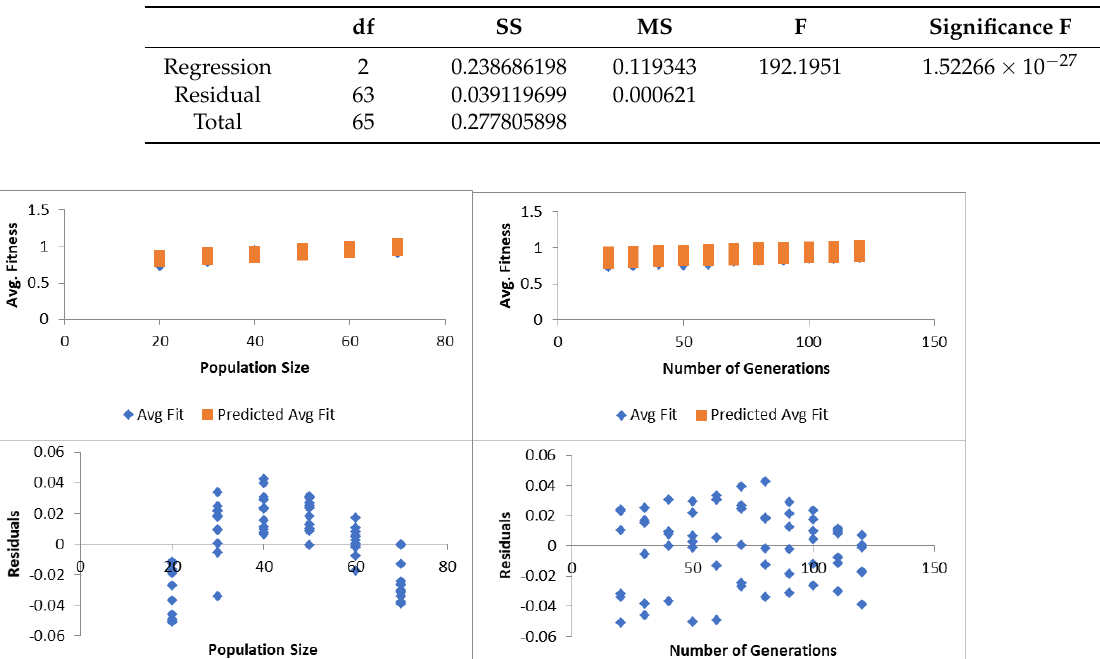
Table 5. ANOVA table.